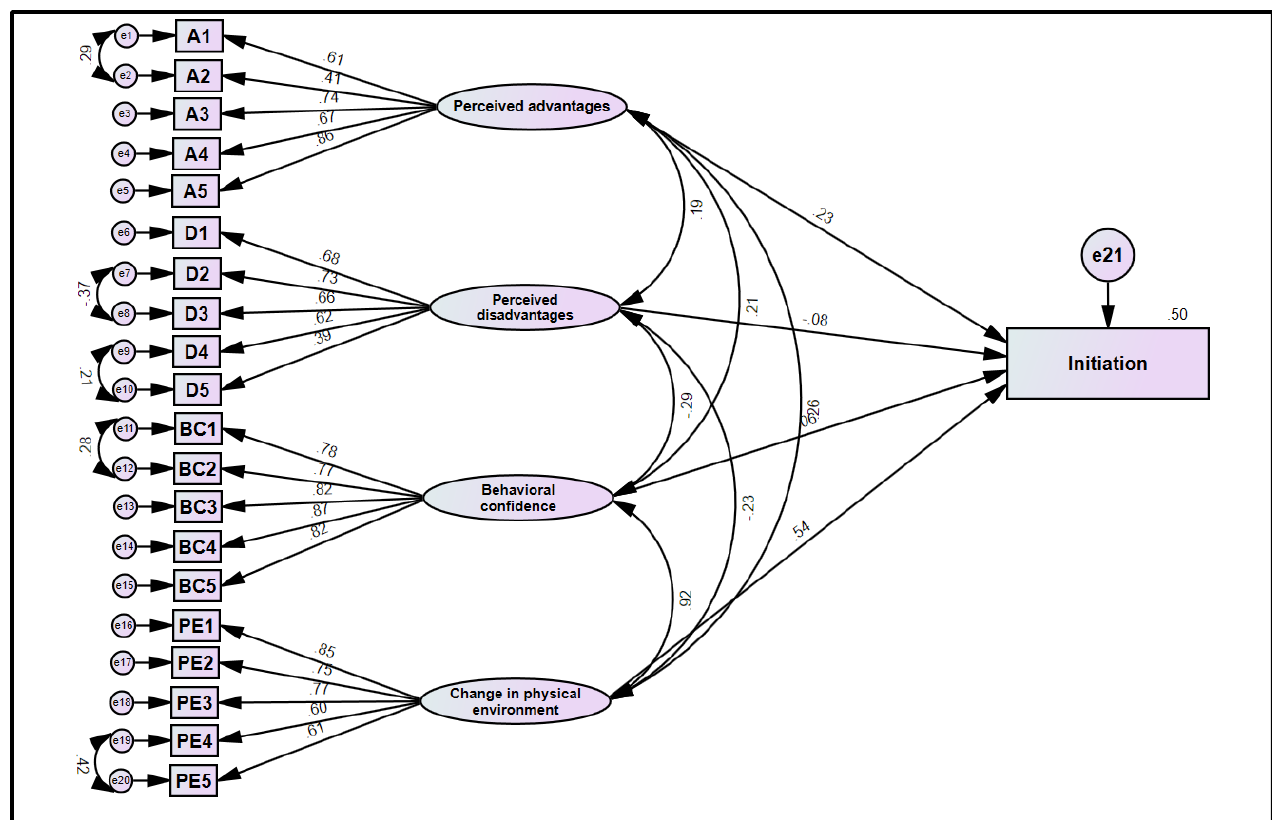
Figure 4. Structural model of initiating vaping quitting behavior. Figure description: The standardized loadings in this model are correlations between the indicator or manifest variables (in boxes) and the latent factors (ovals). The double- headed arrows among the latent factors (ovals) represent correlations. The double-headed arrows between error terms represent correlations among the errors. A1-A5 represents 5 items of “perceived advantages,” D1-D5 represents 5 items of “perceived advantages,” BC1-BC5 represents 5 items of “Behavioral confidence,” and PE1-PE5 represents the 5 items of “Changes in the Physical Environment.”